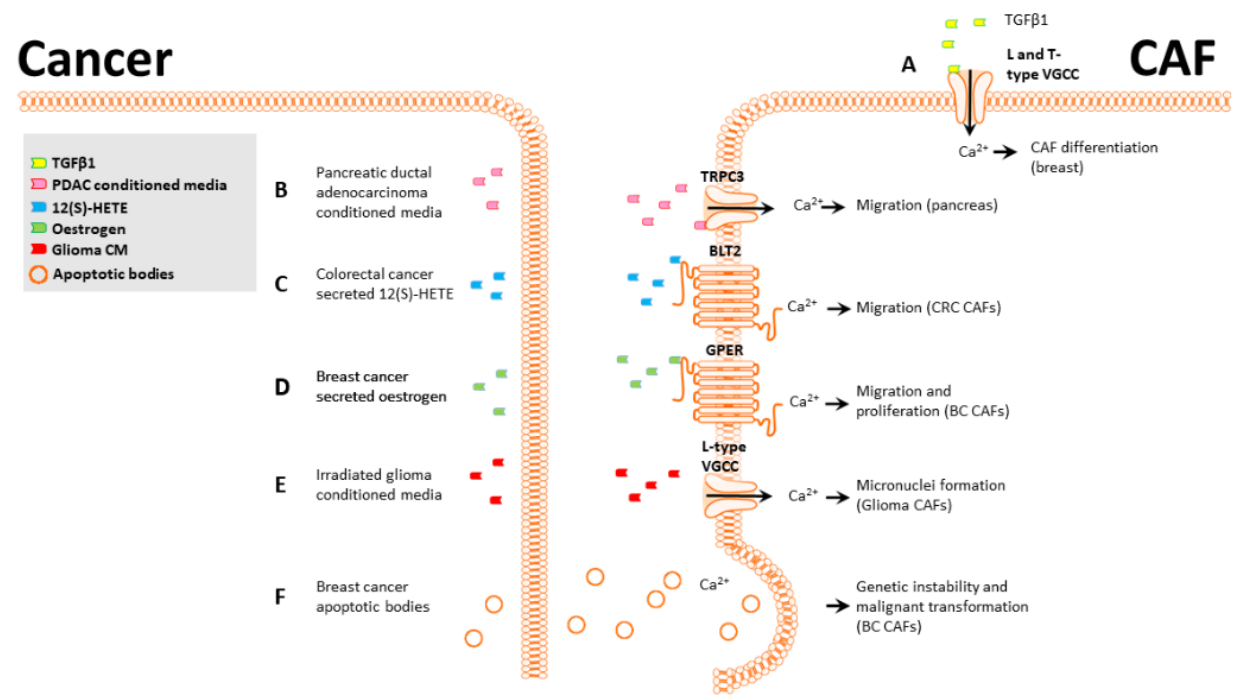
Figure 2. Ca 2+ -mediated phenotypic changes in CAFs. ( A ), TGFβ1-induced breast CAF differentiation is partially mediated by L and T-type VGCCs. ( B ), PDAC-conditioned media activate CAF TRPC3, and the Ca 2+ influx promotes CAF migration. ( C ), CRC-secreted 12(S)-HETE activates the CAF BLT2 receptor and induces an increase in [Ca 2+ ] CYT . ( D ), Breast cancer- secreted estrogen activates CAF GPER, increasing [Ca 2+ ] CYT and promoting CAF migration and proliferation. ( E ), Irradiated glioma-conditioned media activate CAF L-type VGCCs, and the Ca 2+ influx promotes genetic instability and micronuclei formation. ( F ), Breast CAFs can phagocytose breast cancer apoptotic bodies in a Ca 2+ -dependent manner; this promotes horizontal gene transfer and malignant transformation in CAFs.